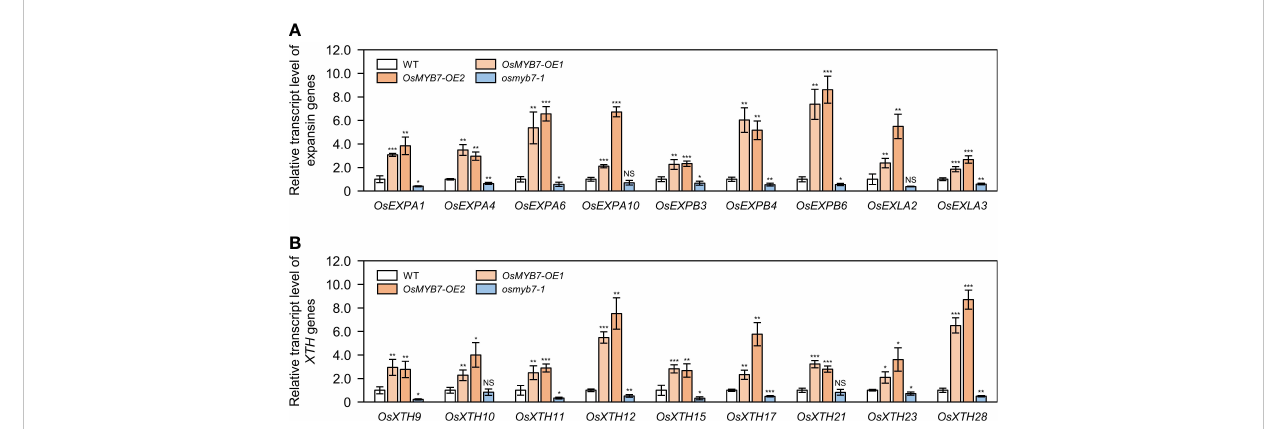
FIGURE 7 Expression analysis of cell elongation-related genes at the lamina joint. (A, B) Relative transcript levels of expansin (A) and XTH (B) genes in WT, OsMYB7-OE1 , OsMYB7-OE2 , and osmyb7-1 plants. Total RNA samples obtained in Figure 4A were used for RT-qPCR analysis. The expression level of each examined gene was normalized to that of GAPDH , and shown relative to WT levels, which were set to 1. Data are presented as means ± SD ( n = 4); asterisks indicate signi fi cant differences as determined by two-tailed Student ’ s t -test (* P < 0.05, ** P < 0.01, and *** P < 0.001). These experiments were carried out twice with independent biological replicates, and similar results were obtained. NS, not signi fi cant; XTH, xyloglucan